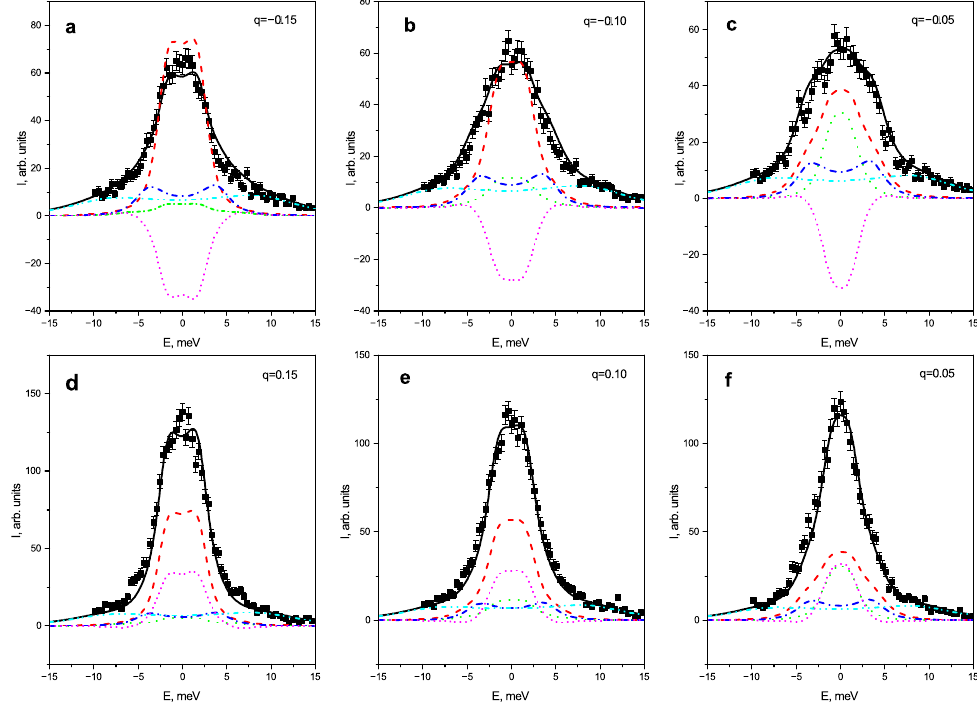
Figure 2. IXS spectra of PZT2.4 at two sides of M-point at 550 K. Panels ( a – c ) correspond to the negative q values − 0.15 ( a ), − 0.10 ( b ) and − 0.05 ( c ), and panels ( d – f ) to the positive q values 0.15 ( d ), 0.10 ( e ) and 0.05 ( f ). The experimental data are represented by squares with error bars, solid lines correspond to (black in the online version) the overall fit, dashed (red) and dash-dotted (blue) lines show contributions of the unperturbed TA and LA modes, while loosely dotted lines (green) represent the AFD mode, dash dot dot (cyan) lines are used for high-energy optic mode, and dotted lines (magenta) show the contribution of mode